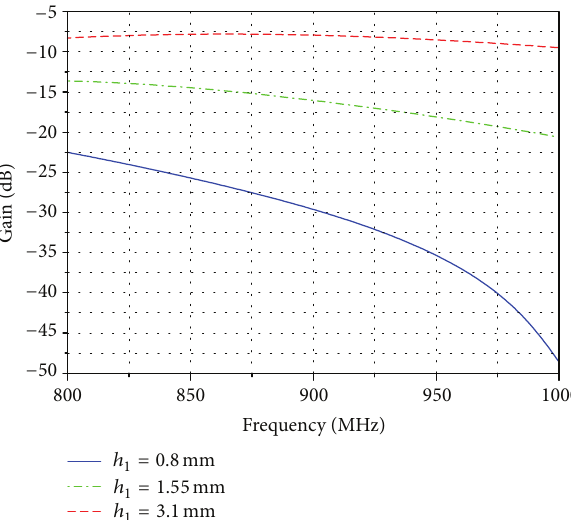
Figure 3: Antenna input impedance for different lengths of the patch.